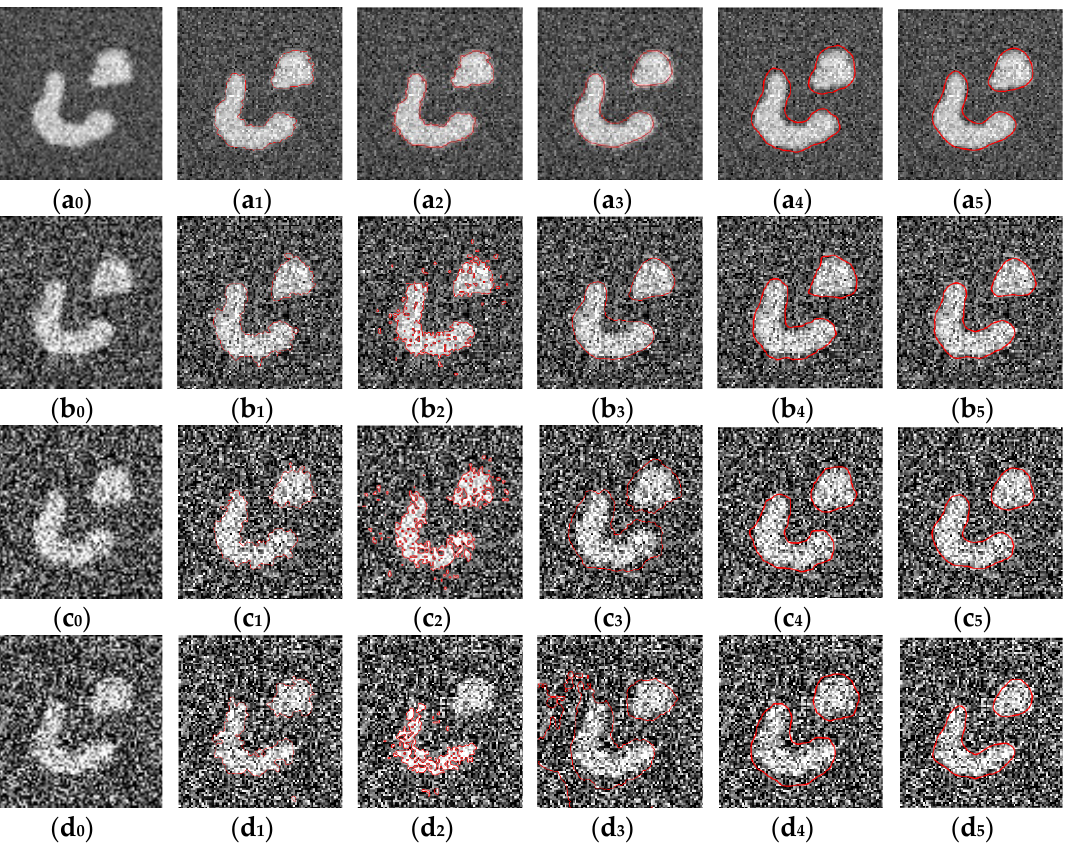
Figure 7. Image segmentation results for different Gaussian noise levels: ( a 0 -d 0 ) are Gaussian noise images with a mean of 0 and variances of 0.01, 0.05, 0.09, and 0.13, respectively. ( a 1 -d 1 ) are the segmentation results of the LIC model. ( a 2 -d 2 ) are the segmentation results of the LBF model. ( a 3 -d 3 ) are the segmentation results of the model from [16]. ( a 4 -d 4 ) are results of the model from [27]. ( a 5 -d 5 ) are results of the NFD-LIF model. Table 2. Running Time and Number of Iterations of the Active Contour Model with Different Gaussian Noise